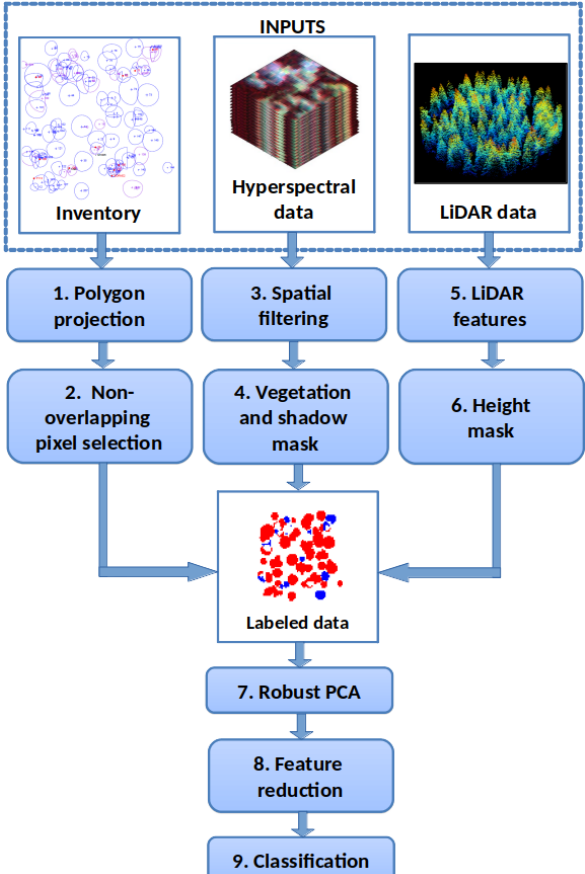
Figure 1: Semantic segmentation flowchart for forest tree species classification by integrating HI and LiDAR